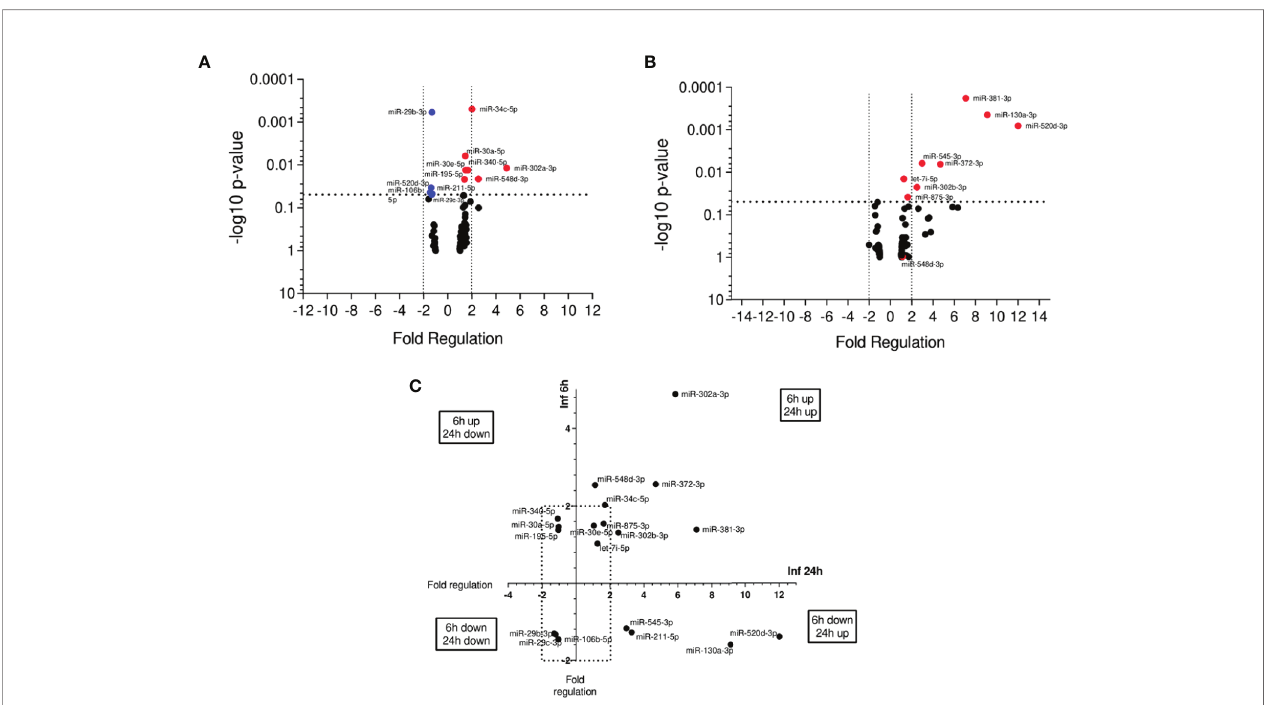
FIGURE 2 | miRNA pro fi les of L. braziliensis infected THP-1-macrophages. Volcano plot of differential expression of miRNA in L. (V.) braziliensis promastigote- infected THP-1 macrophages in relation to non-infected cells at 6 h (A) and 24 h (B) post-infection compared to uninfected-macrophages. Each dot represents one miRNA. Red dots indicate the up-regulated miRNAs, and the blue dots represent the down-regulated miRNAs (P < 0.05). Black dotted line corresponds to p = 0.05, log 10. The relative up- and down-regulation of miRNAs, expressed as boundaries of 2 or -2 of Fold Regulation, respectively. P-value was determined based on two- tailed Student ’ s t test. Signi fi cantly expressed miRNAs in different times distributed in four groups (C) . Experiments were repeated three